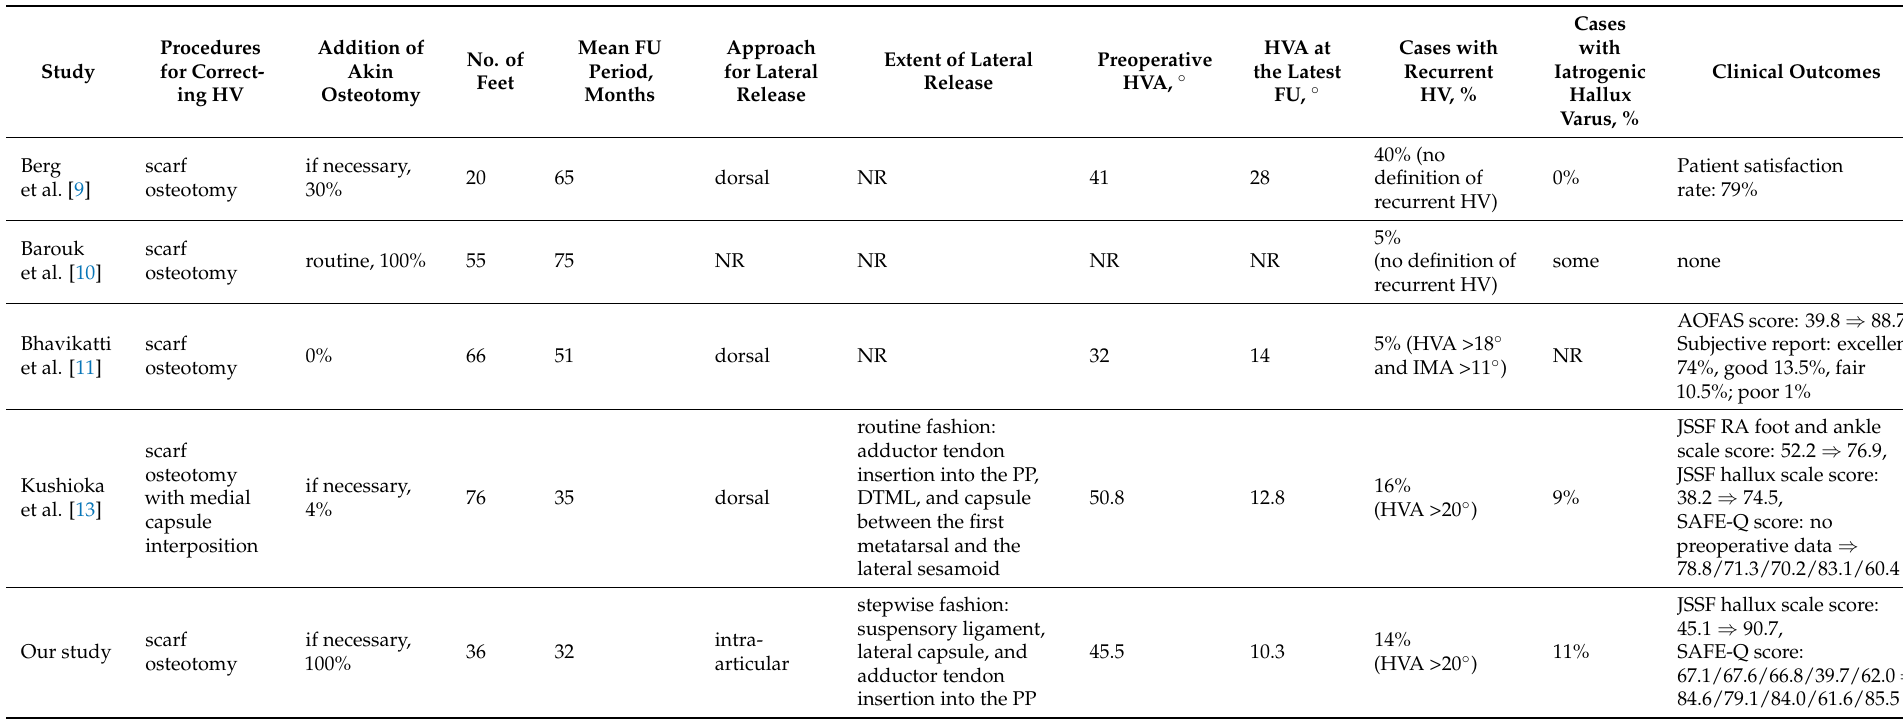
Table 4. Literature reports on the clinical and radiographic outcomes of scarf osteotomy for correcting hallux valgus deformity in patients with rheumatoid